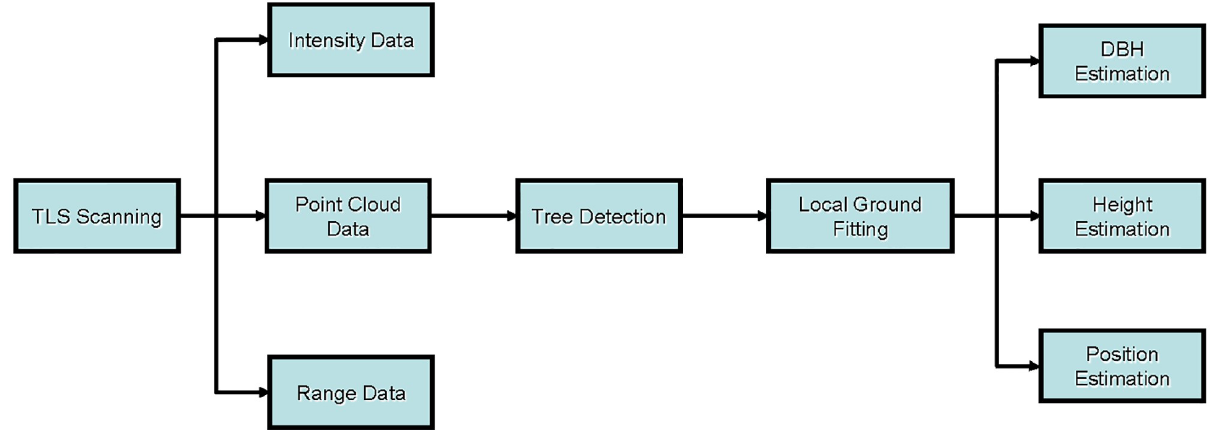
Fig 4. The flowchart of the data acquisition and processing of the BEE scanner.